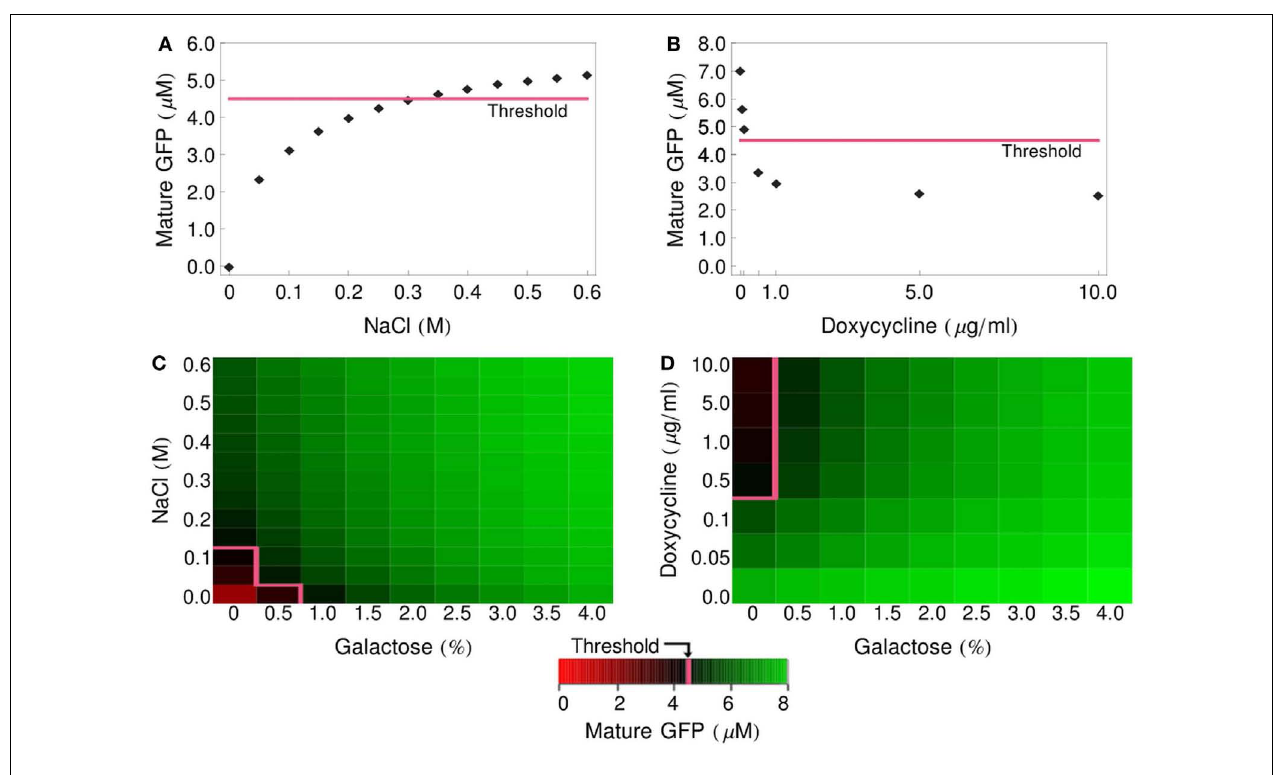
with various concentrations of NaCl and galactose. (D) Production of GFP by the IMPLIES gate upon treatment with various concentrations of doxycycline and galactose. On all graphs, the pink line depicts the threshold above which cells are scored as GFP-positive (4.5 µ M GFP).